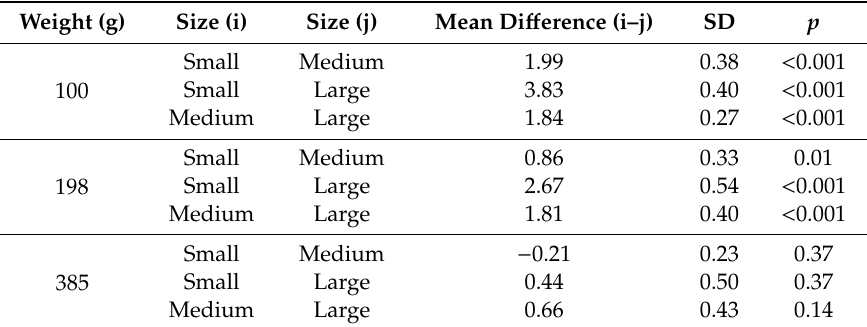
Figure 2. Interaction e ff ects of size and weight of cookie box on preference. Table 6. Preference comparison of the three cookie box sizes.